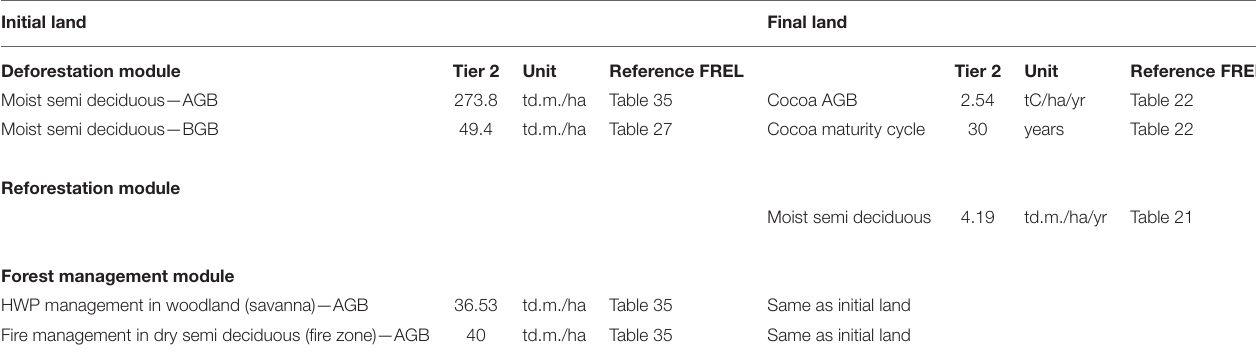
TABLE 7 | National data used for the